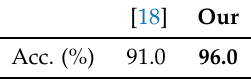
Table 8. Comparison to state-of-the-art research work of [18], using our own